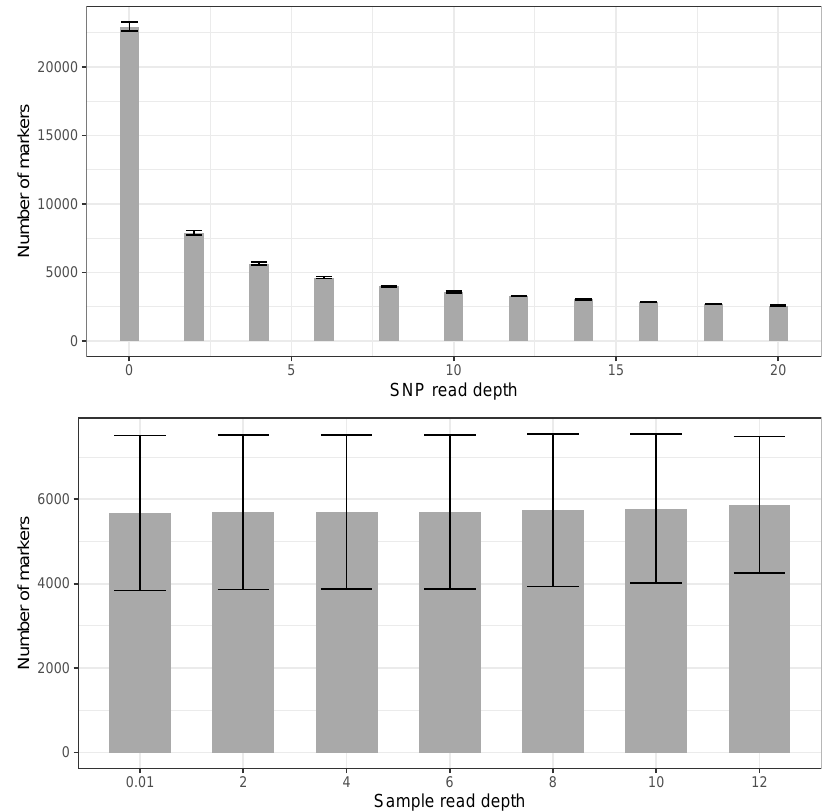
Figure 2. Number of markers. Number of SNPs generated under different SNP read depth thresholds ( top plot ) as well as under different sample read depth thresholds ( bottom plot ). The confidence limits represent variance in the number of SNPs across different sample read depth/SNP read depth